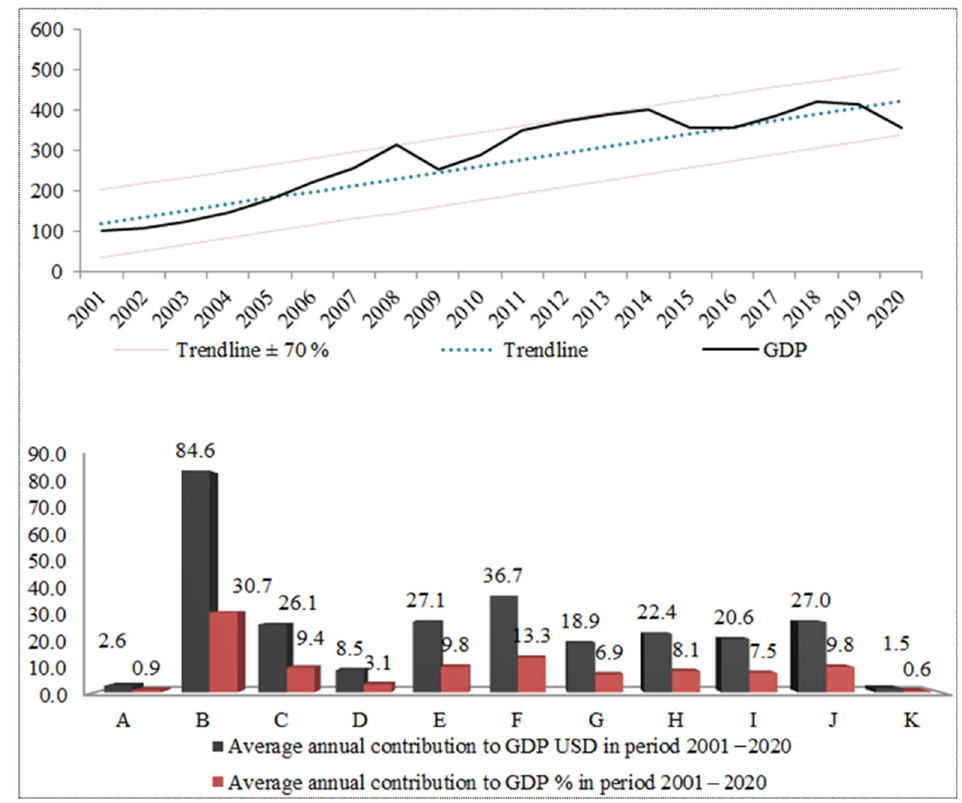
Figure 1. UAE total GDP broken down by economic sector for the period of 2001–2020. A: agriculture, livestock, and fishing; B: mining and extractive industries; C: manufacturing industries; D: electricity, gas, and water supply; E: construction; F: wholesale and retail trade and repairing services; G: transport, storage, and communications; H: corporate finance; I: real estate and business services; J: government services, etc.; K: domestic (consumer) services.